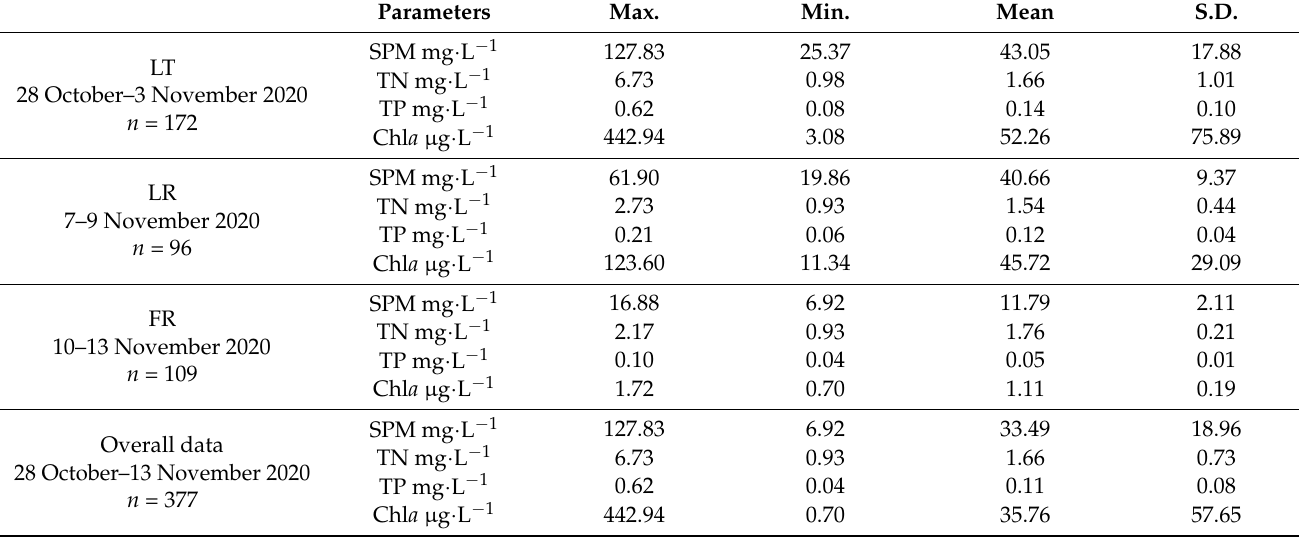
Table 2. Statistical analyses of in situ measurements were collected from three study areas. Max.